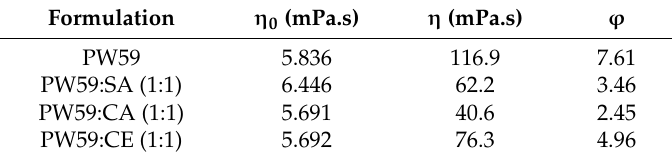
Table 2. Viscosities and volume fractions of the 20% drug-loaded formulations at shear stress of 8 Pa.